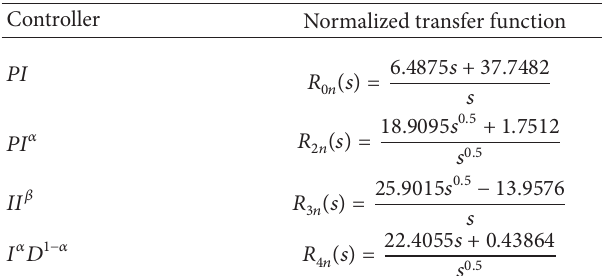
Table 4: Example 2